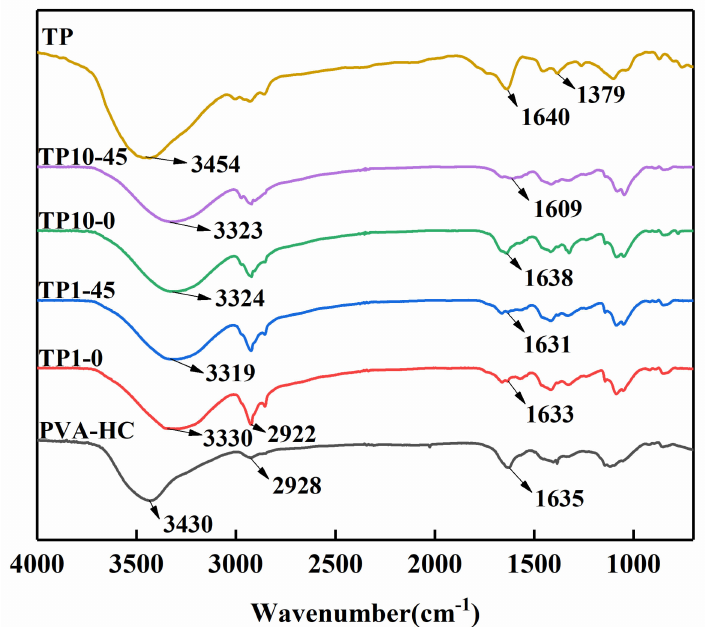
Figure 1. FT-IR of tea polyphenols (TP), poly (vinyl alcohol) (PVA)-hemicellulose (HC), and different mass ratios of PVA–HC/TP under different ultrasonic